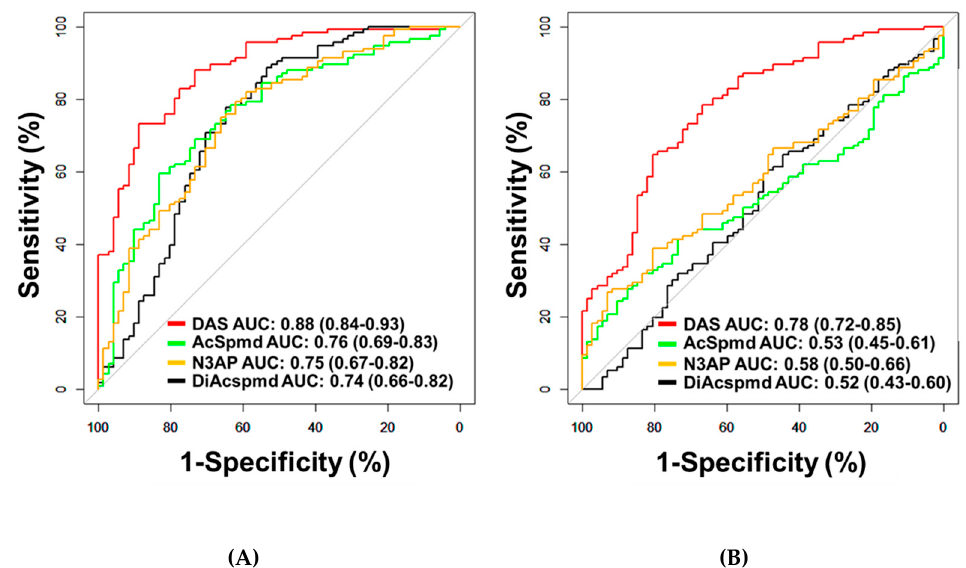
Figure 1. Classification performances of plasma polyamines in the Test Set. ( A,B ) Area under the curve (AUC) of DAS for delineating all cases ( n = 116) from healthy controls ( n = 71) ( A ) or patients with benign pelvic masses ( n = 72) ( B ).